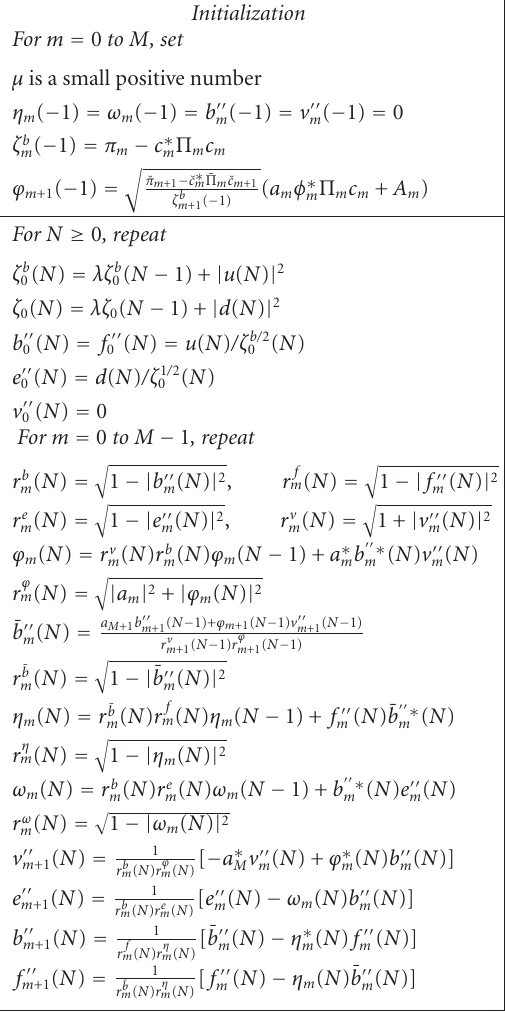
Algorithm 4: Normalized extended RLS lattice